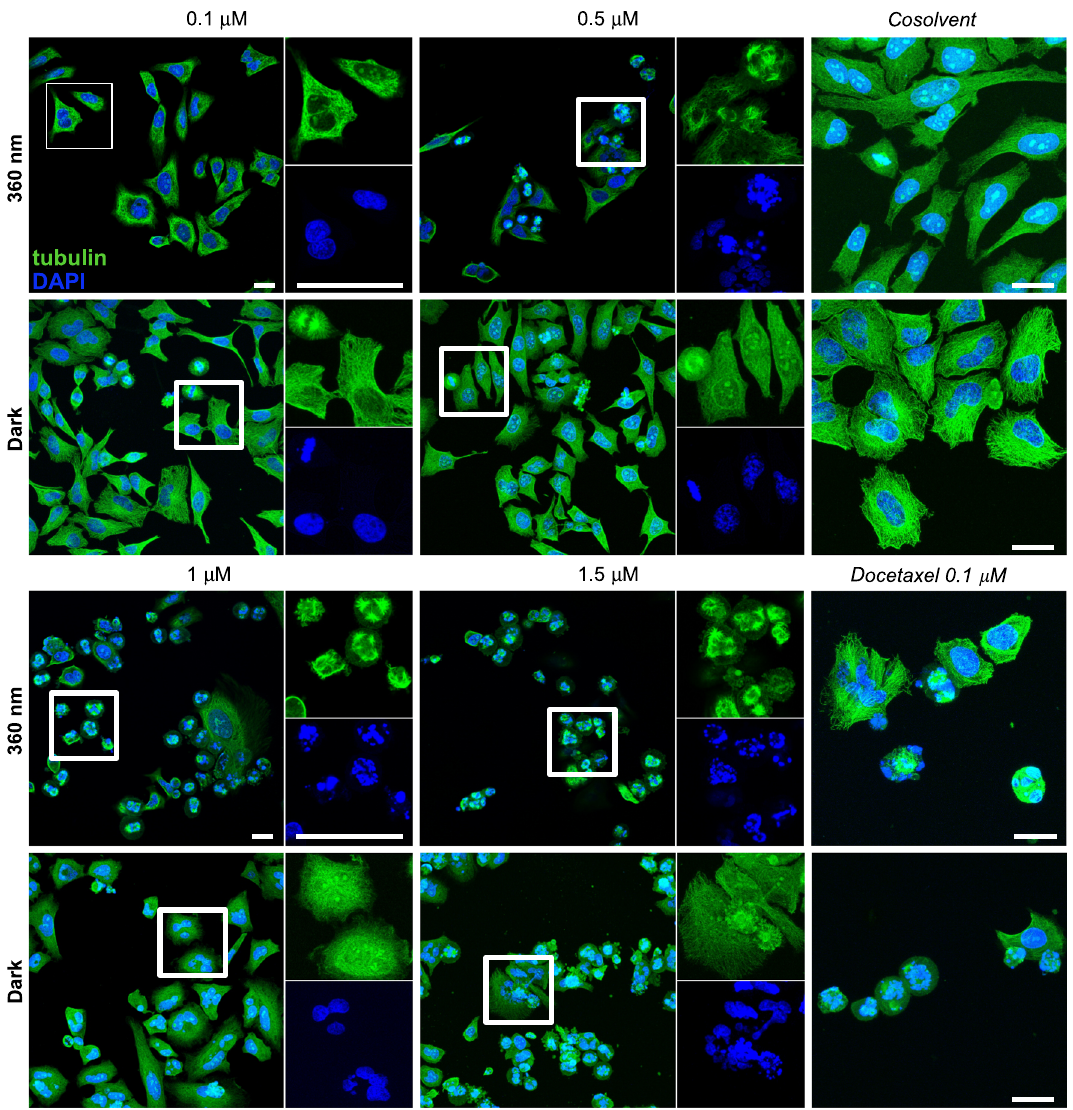
Fig. 3 AzTax3MP light-dependently disrupts MTs in cultured cells. Immuno fl uorescence staining indicates dose- and light-dependent disruption of MT organisation, mitotic completion, and cell viability. HeLa cells treated with AzTax3MP , docetaxel, or DMSO cosolvent only for 24 h; α -tubulin in green, DNA in blue; docetaxel positive control at 0.1 µ M; DMSO cosolvent at 1% in all conditions; scale bars 25 µ m (staining was repeated twice after two independent experiments and evaluated each time by at least two scientists independently).